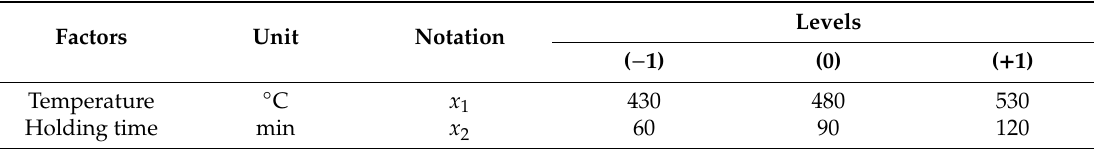
Table 2. Factors and levels for the response surface study.